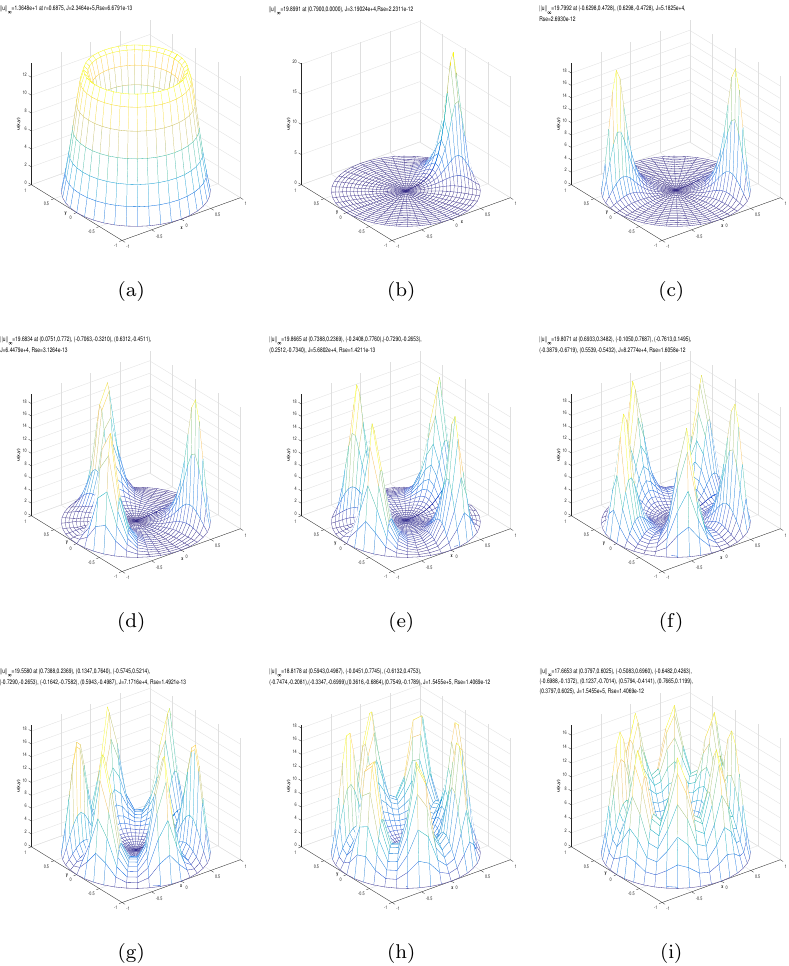
Figure 5. Nine positive solutions to problem (1.1) with p = 3 , l = 2 , λ = 40 and κ = − 1, which are O (2), Σ 1 , Σ d , D 3 , D 4 , D 5 , D 6 , D 7 and D 8 symmetric,